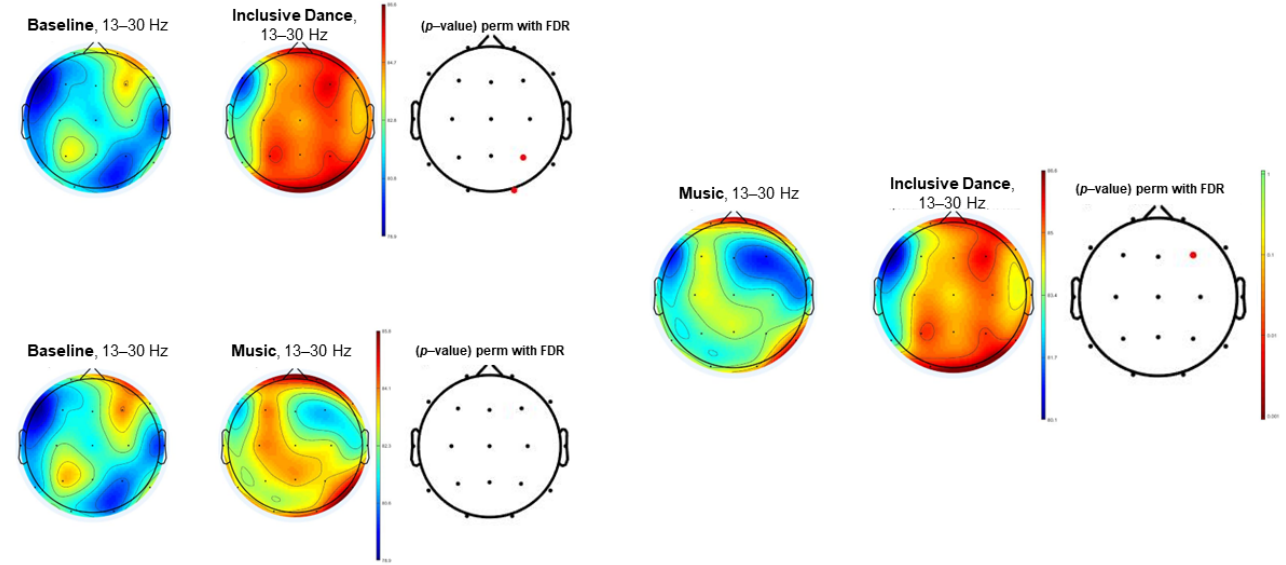
Figure 3. EEG topographic maps in the beta power spectrum (13–30 Hz) of the comparison between baseline, inclusive dance, and listening to music conditions. Significant comparisons ( p -value < 0.05) have been highlighted in red.